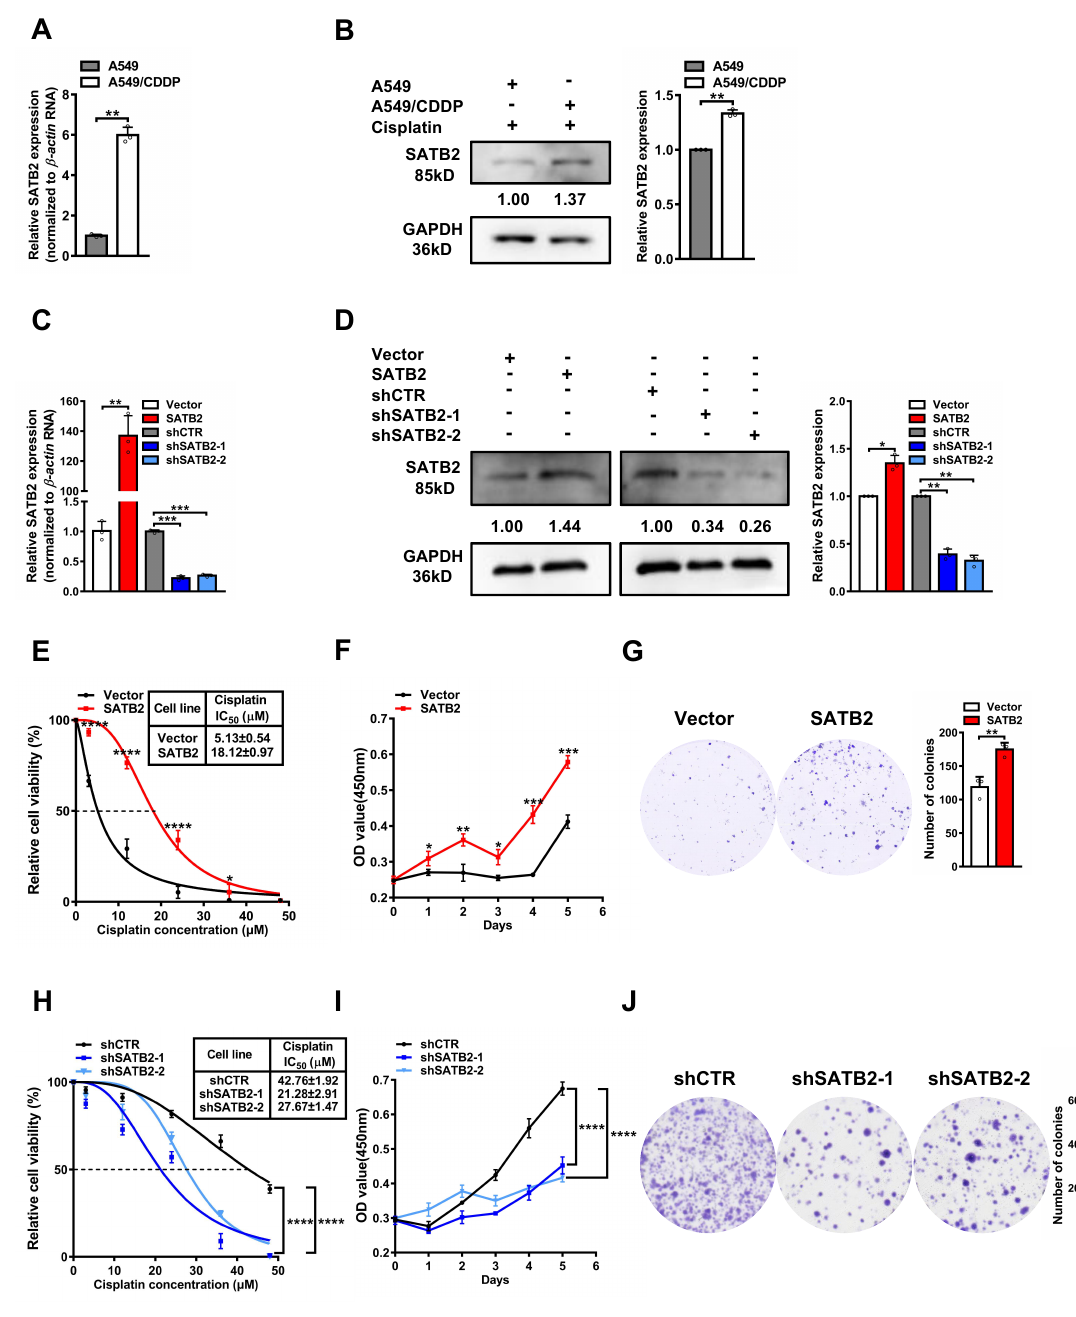
Figure 4. SATB2 promotes cisplatin resistance in LUAD cells. ( A , B ) Expression levels of SATB2 in A549 and A549/CDDP cells were measured by RT-qPCR and Western blot. ( C , D ) The effect of SATB2 overexpression and knockdown were determined by RT-qPCR and Western blot. ( E ) Comparison of cisplatin IC 50 values between the A549-Vector and A549-SATB2 cells. ( F , G ) With cisplatin treatment, the capacities of cell proliferation and colony formation in A549-SATB2 cells and the corresponding control cells were examined using CCK8 and colony formation assays. ( H ) Comparison of cisplatin IC 50 values between A549/CDDP-shCTR and A549/CDDP-shSATB2 cells. ( I , J ) With cisplatin treat- ment, the capacities of cell proliferation and colony formation in A549/CDDP-shSATB2 cells and the corresponding control cells were examined using CCK8 and colony formation assays. Data are presented as the mean ± standard deviation. * p < 0.05, ** p < 0.01, *** p < 0.001, **** p <